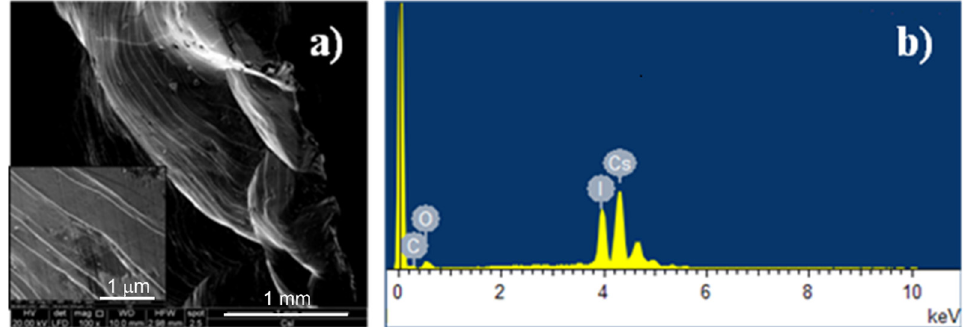
Figure 1. SEM micrograph of the CsI(Tl) crystal surface ( a ) and related EDS spectrum ( b ). The inset of ( a ) shows a magnification of the surface dislocations.